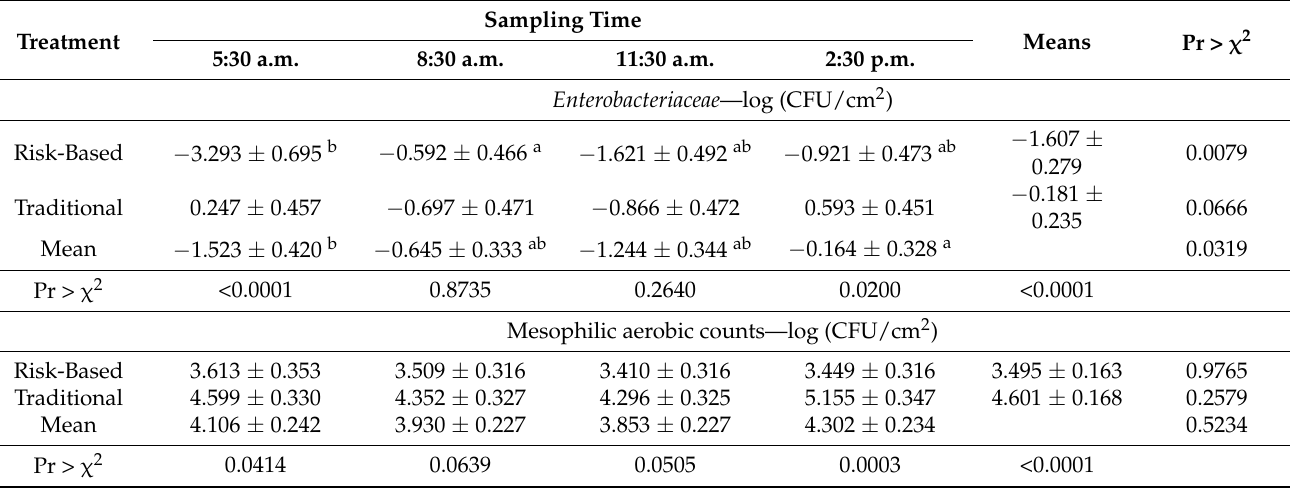
Table 3. Means and standard deviations of the Enterobacteriaceae and mesophilic aerobic counts on the surface of the pig carcasses in function of the employed inspection system and the time of sample collection.